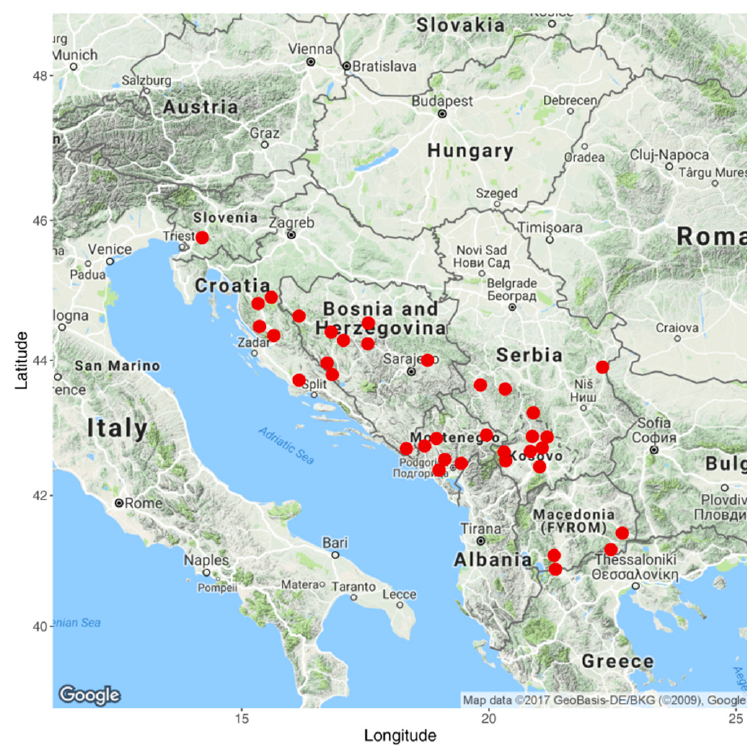
Figure 1. Map of collection sites of the evaluated maize landraces. Table 1. Passport and morphological data of the evaluated maize landraces and testers used. Ab- breviations: GD: genotype designation; AN: accession number; CC: country of collection; DT: days to tasseling; DS: days to silking; PH: plant height; EH: ear height; KRN: number of kernel rows;